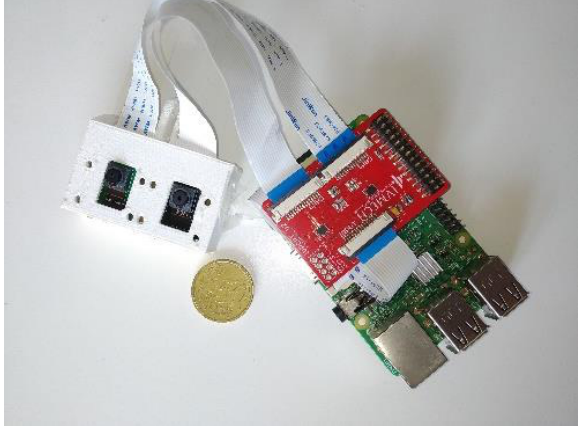
Figure 1. Raspberry-based device used in this